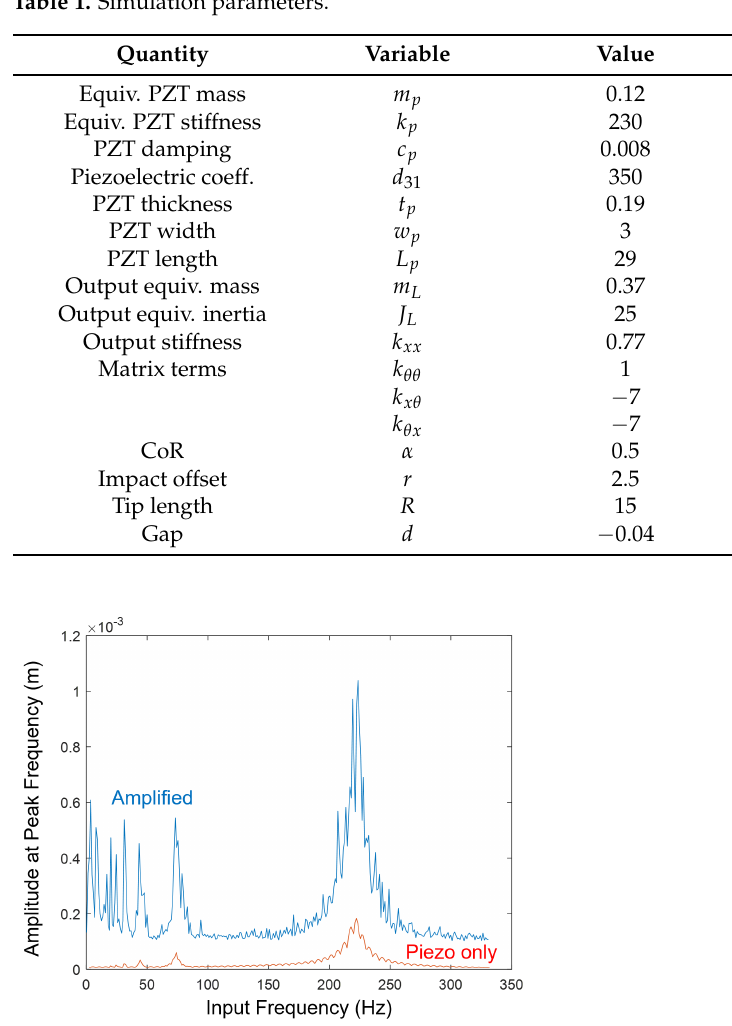
Figure 3. Magnitude of largest output frequency component versus square wave input